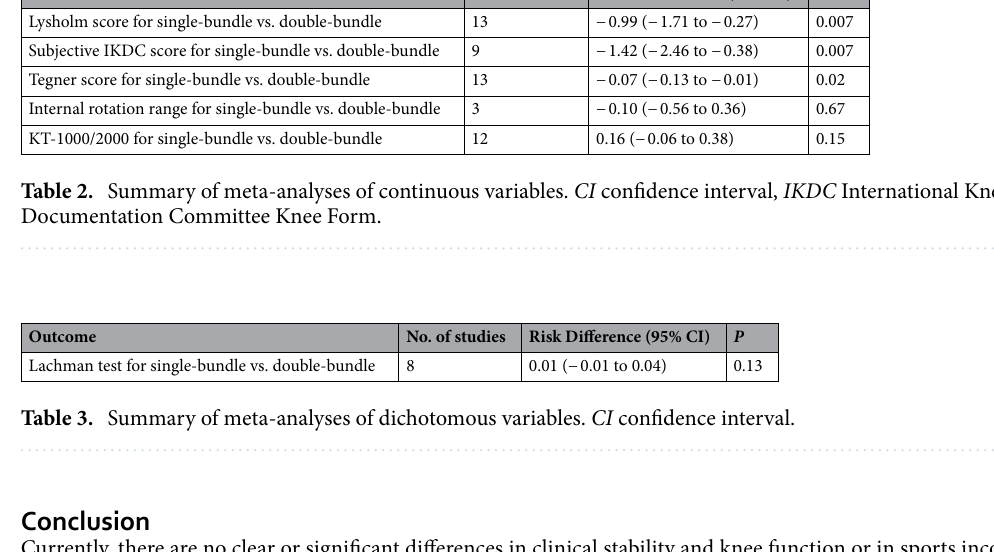
Outcome No. of Studies Mean Differences (95% CI) P Lysholm score for single-bundle vs. double-bundle 13